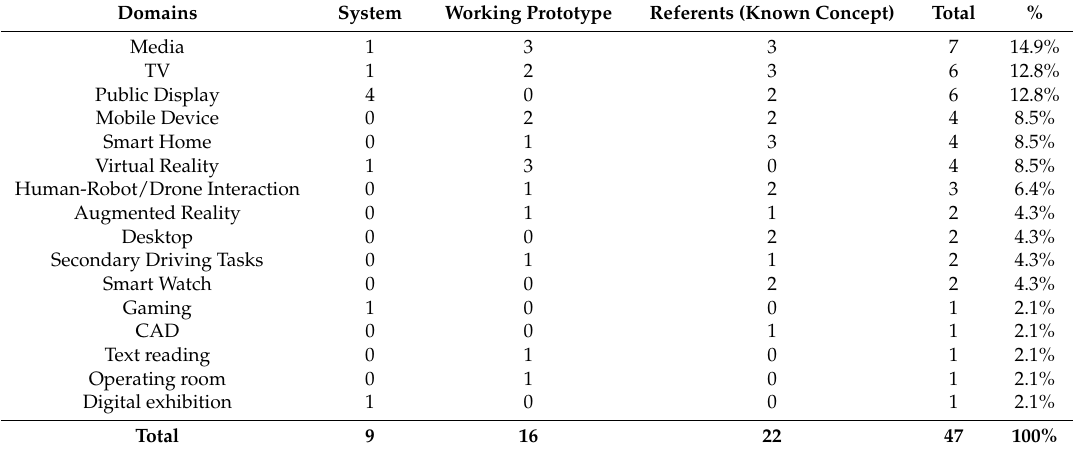
Table 3. Domains and technological design maturity of applications employed in elicitation studies